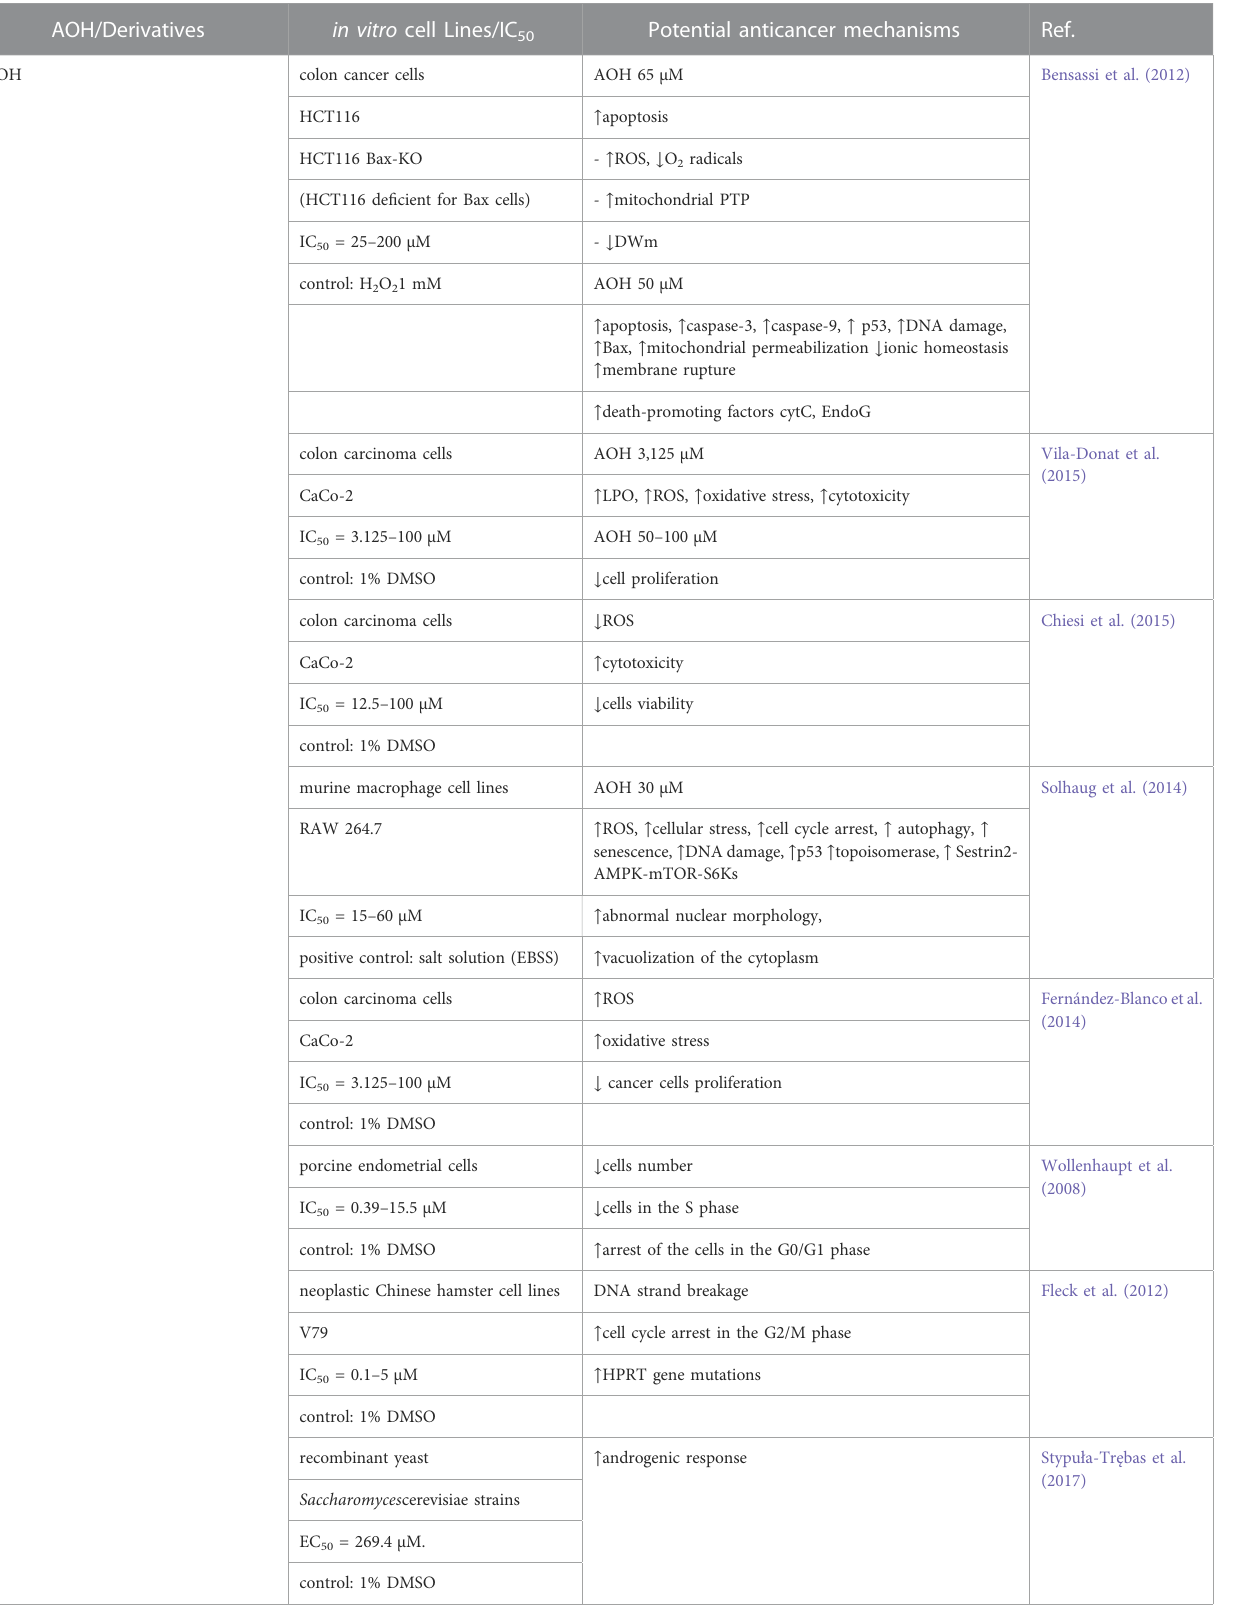
TABLE 1 Anticancer effects of alternariol and/or its derivatives in different in vitro experimental studies. AOH/Derivatives in vitro cell Lines/IC